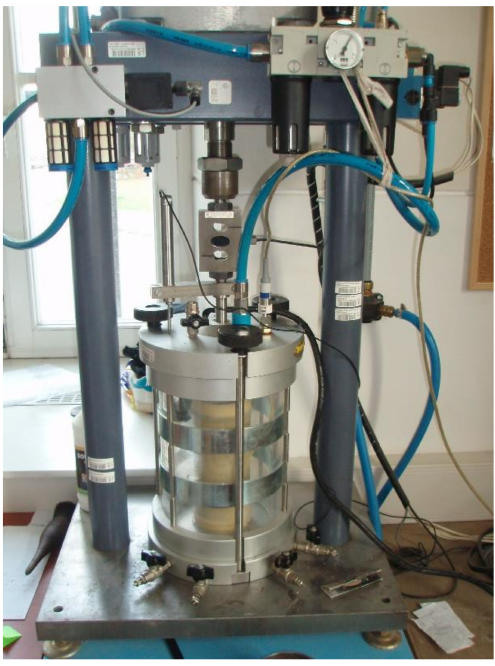
Figure 2. CTT device.